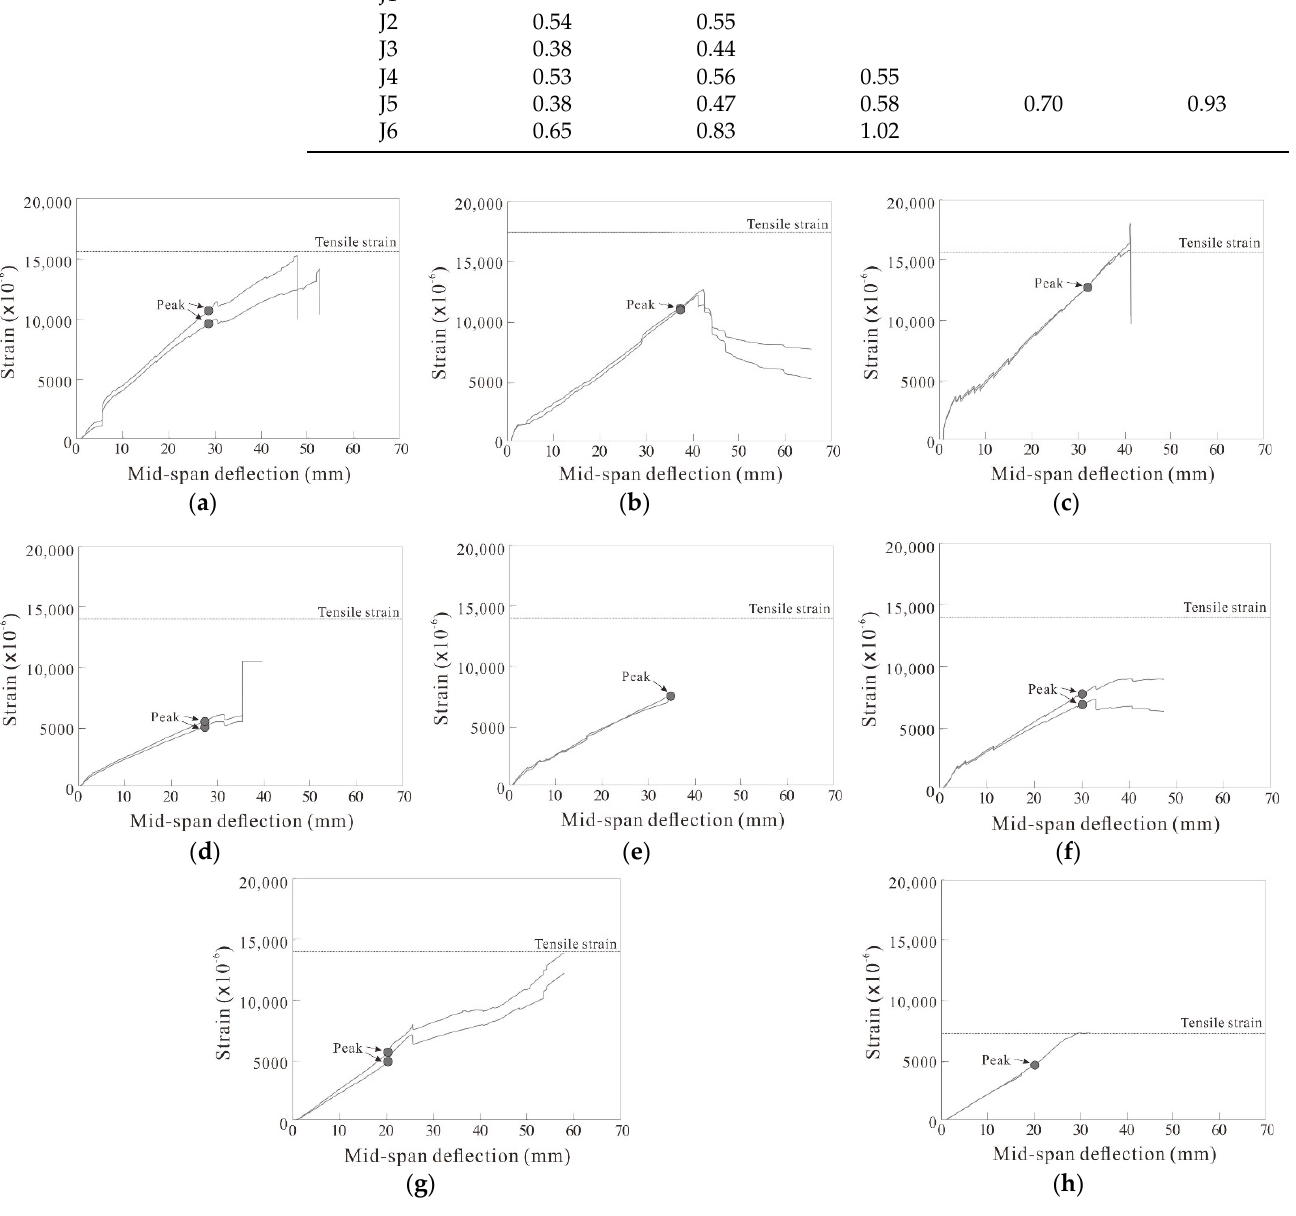
Figure 13. Relationship between the mid-span deflection and strain in the specimens: ( a ) G1; ( b ) G2; ( c ) G3; ( d ) J2; ( e ) J3; ( f ) J4; ( g ) J5; and ( h ) J6.